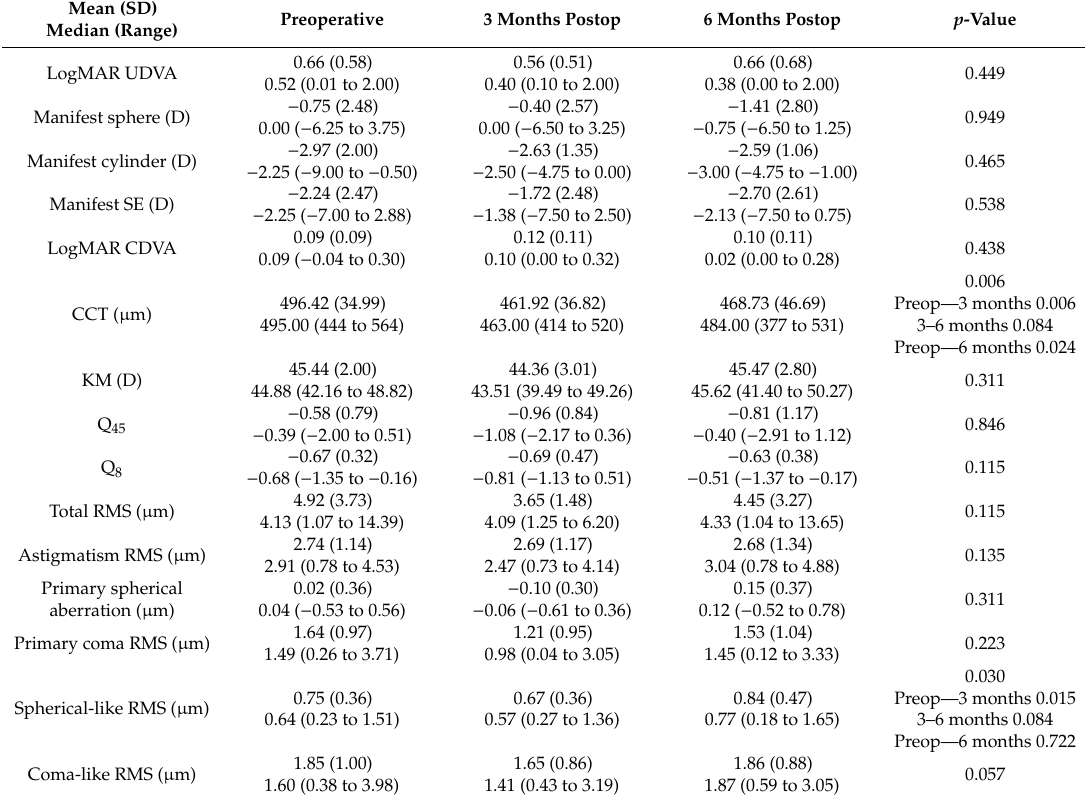
Table 1. Visual, refractive, corneal topographic, and aberrometric outcomes during the follow-up in the analyzed sample. Abbreviations: SD, standard deviation; D, diopters; UDVA, uncorrected distance visual acuity; SE, spherical equivalent; CDVA, corrected distance visual acuity; CCT, central corneal thickness; KM, mean keratometry; Q 4.5 , asphericity in the central 4.5 mm corneal area; Q 8 , asphericity in the central 8.0 mm corneal area; RMS, root mean square.